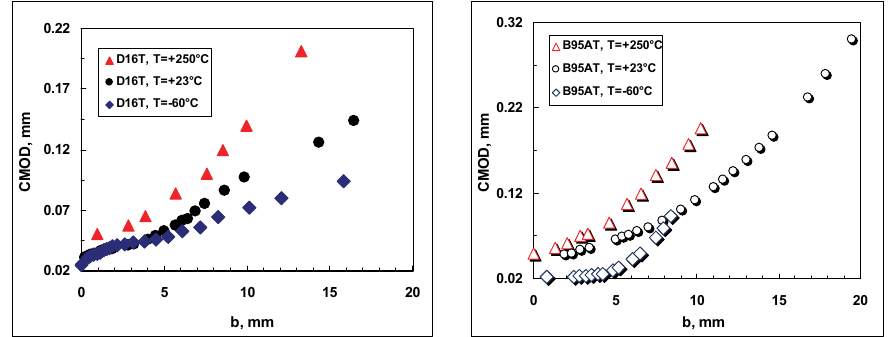
Figure 5: Relationship between CMOD and crack length on free surface of hollow specimen under different temperature conditions.